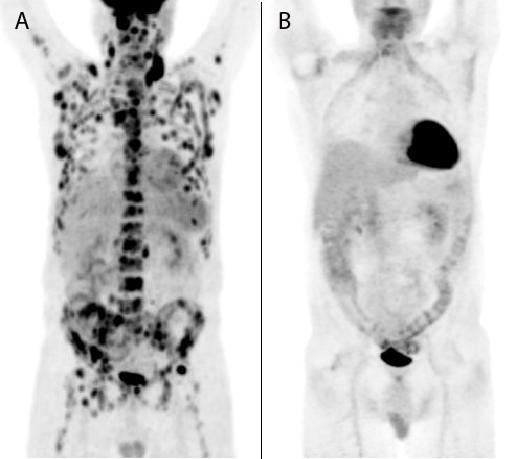
The scout film of the positron emission tomography-computed tomography (PET-CT) scan performed prior to this first round of chemotherapy (a) demonstrates diffuse regions of uptake involving multiple ribs, multiple vertebral bodies, the pelvis, the sternum and the scapula. There is also increased fluorodeoxyglucose (FDG) uptake in multiple bilateral lymph node regions extending from the jugular, supraclavicular, mediastinal, retroperitoneal, pelvic and inguinal regions, consistent with Hodgkin's lymphoma. There is increased FDG uptake in the posterior and right lateral walls of the nasopharynx. About two months after his first round of chemotherapy, a repeat PET-CT scan (b) showed a marked interval decrease in the FDG-avid metastatic burden.